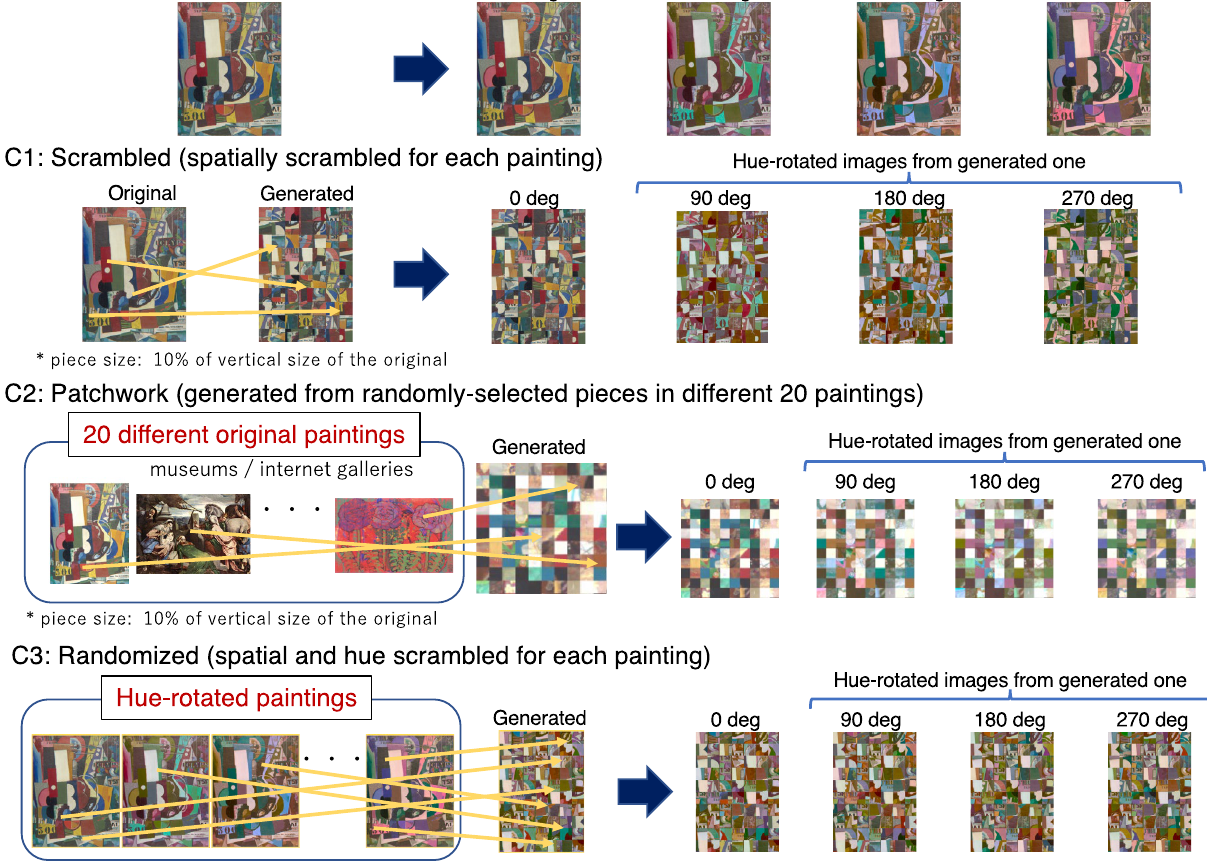
Figure 3. Image scrambling condition. C0 (Original), original and hue‑rotated images are preserved their original spatial form. C1 (Scrambled), each image is divided into a set of small square pieces with a side length of 73 pixels (10% of the height of the image), and the position of the piece is randomized. C2 (Patchwork), each image is divided into a set of small pieces in the same way as C1 and each stimulus is created with 100 randomly selected pieces from 20 different paintings measured at museums or from the galleries on the Internet in Sets 1, 2 and 3. C3 (Randomized), each stimulus is generated from the pieces selected from the hue‑rotated images with a random degree from the original